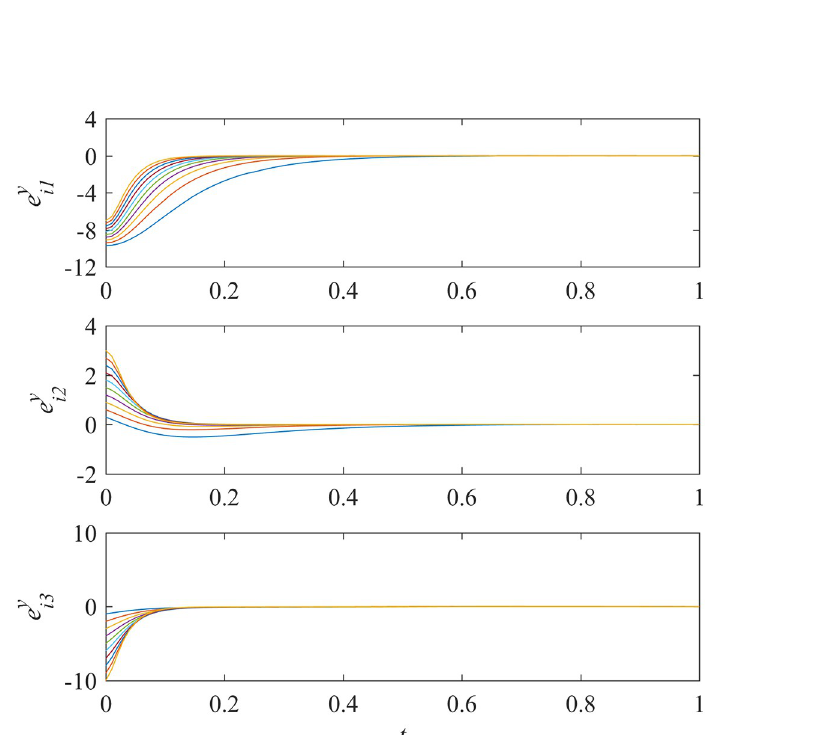
Fig 8. States of error system between the nodes and the isolate node in sub-network Y (Eq (4)).